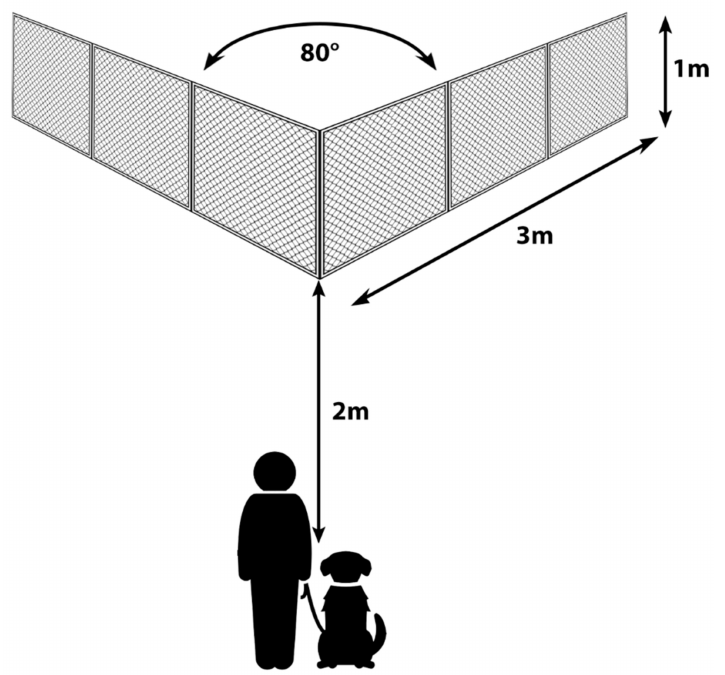
Figure 1. The experimental setup of the detour